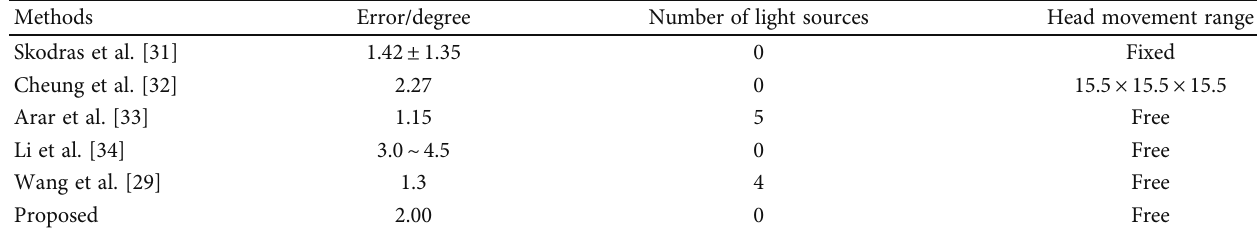
Table 2: Performance comparison with relevant